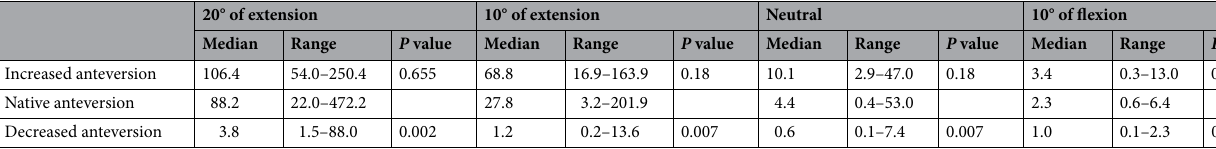
Table 4. Mean surface pressure (kPa) of the iliopsoas muscle when stem anteversion was changed. Values are shown as the median and range. P value are from the Friedman test. For p values of < 0.05 in the Friedman test, individual p values are shown for comparison with native anteversion based on the results of the post hoc test.